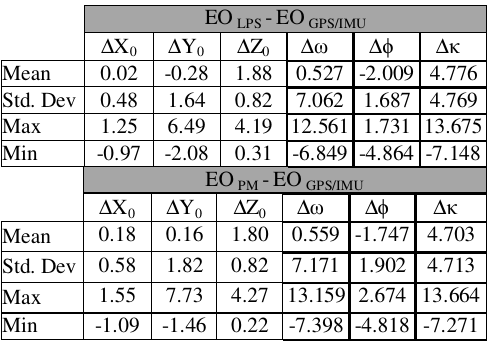
Table 7. Statistics of accuracies of TPs ground coordinates [m]